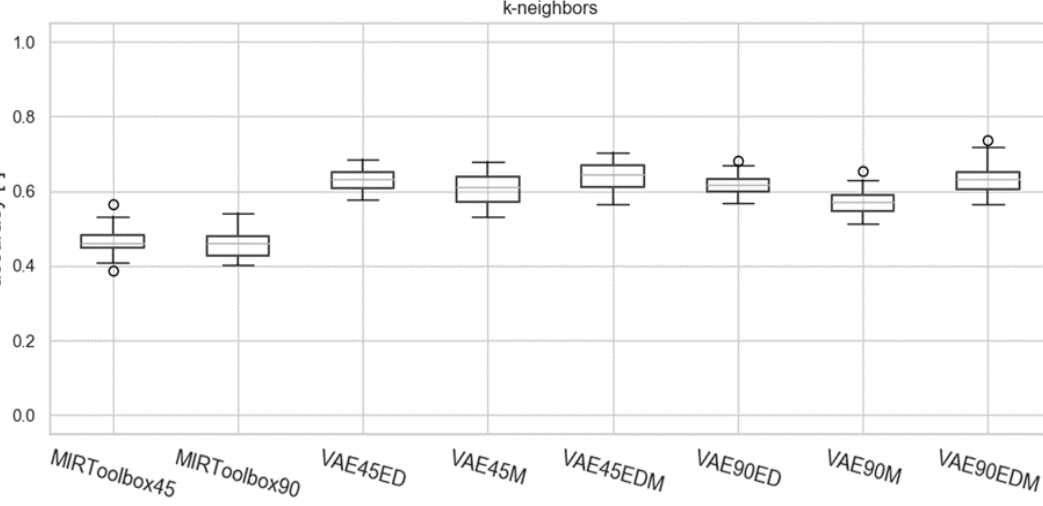
Figure 14. Accuracy obtained based upon the k -NN classifier shown as a boxplot. Table 6. Matrix of p -values obtained for Dunn’s post hoc test associated with the k - NN algorithm.